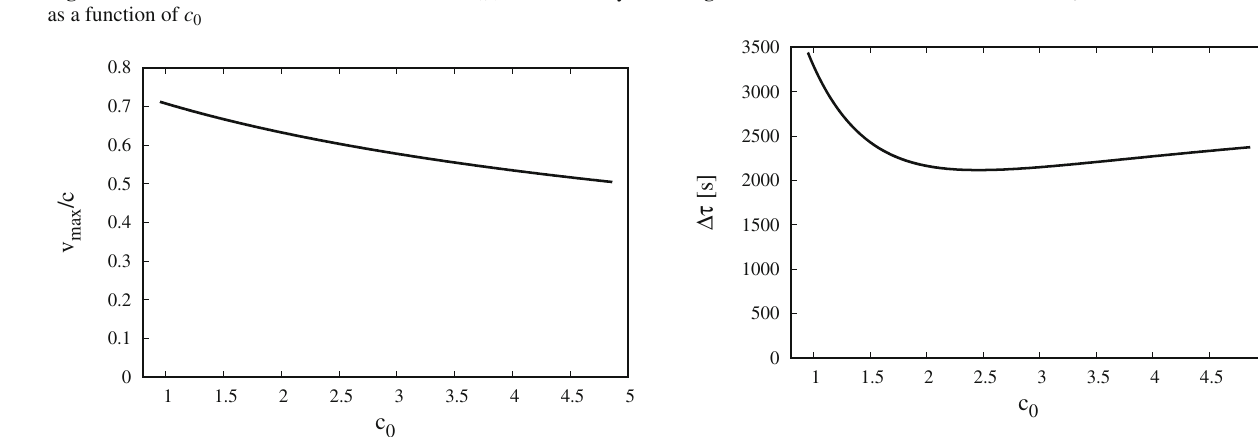
Fig. 8 Coordinate time Δ t as a function of c 0